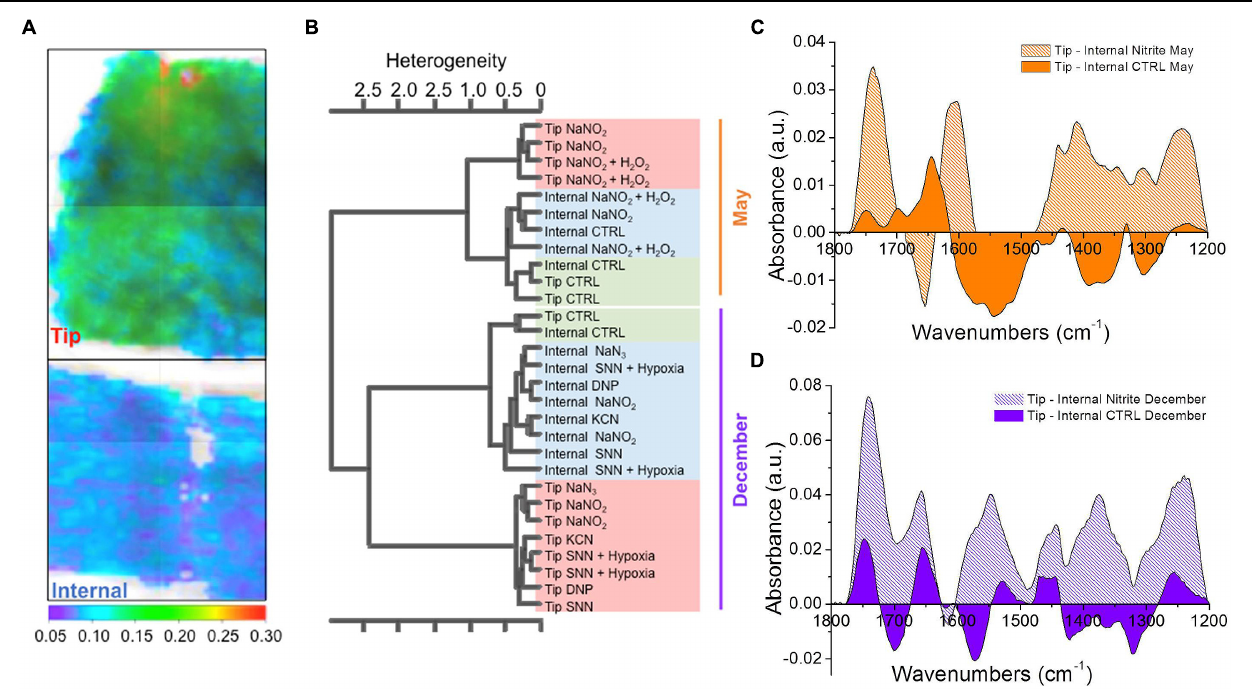
FIGURE 7 | Synchrotron radiation-based Fourier transform infrared (SR-FTIR) spectromicroscopy of A. pinnata roots. (A) Micrograph showing representative SR-FTIR-scanned regions of a root tip and internal part of an abscised root overlain with the respective chemical maps of ratio C = O (non-peptide) signal (1780–1705 cm − 1 ) to the C–O–R signal (1705–1550 cm − 1 ). (B) Cluster analysis of SR-FTIR spectra taken of regions at abscised root tips, internal regions > 1 mm away from